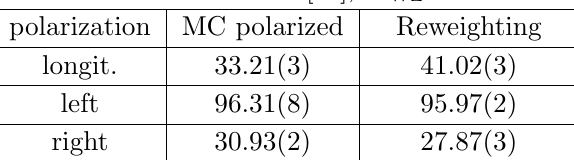
Table 14 . Polarized total cross sections ( ab ) for W + Z scattering in the region M WZ > 200 GeV: results of the reweighting procedure compared with results of the MC calculation with polarized amplitudes. The full set of cuts and neutrino reconstruction are understood.